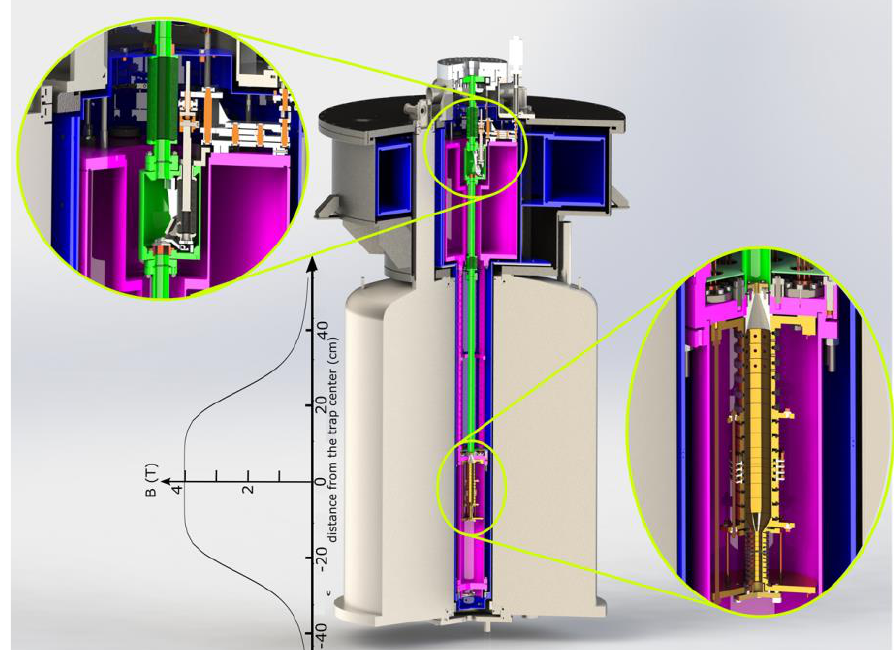
Figure 5. The ALPHATRAP Penning-trap setup. The trap chamber ( right inset ) is connected to the room-temperature beamline (green); A cryogenically operateable valve ( left inset ) allows for sealing the cryogenic section during the measurement. This limits the in-flux of rest-gas atoms from the room-temperature section and allows reaching the close-to-perfect vacuum conditions required for the storage of heavy highly-charged ions. To provide optimal mechanical stability, the cryogenic section is cooled by a specially developed liquid helium